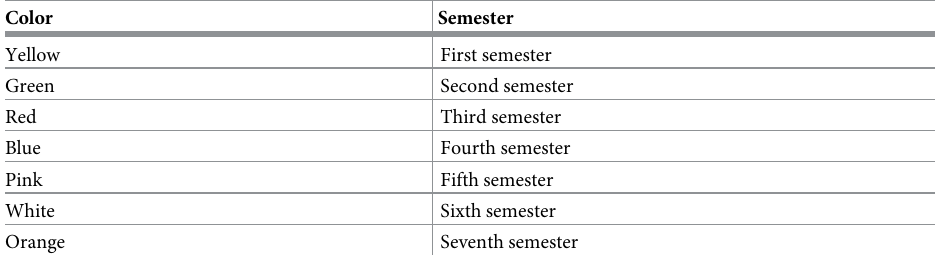
Table 2. Color description for each course in the math curriculum network.